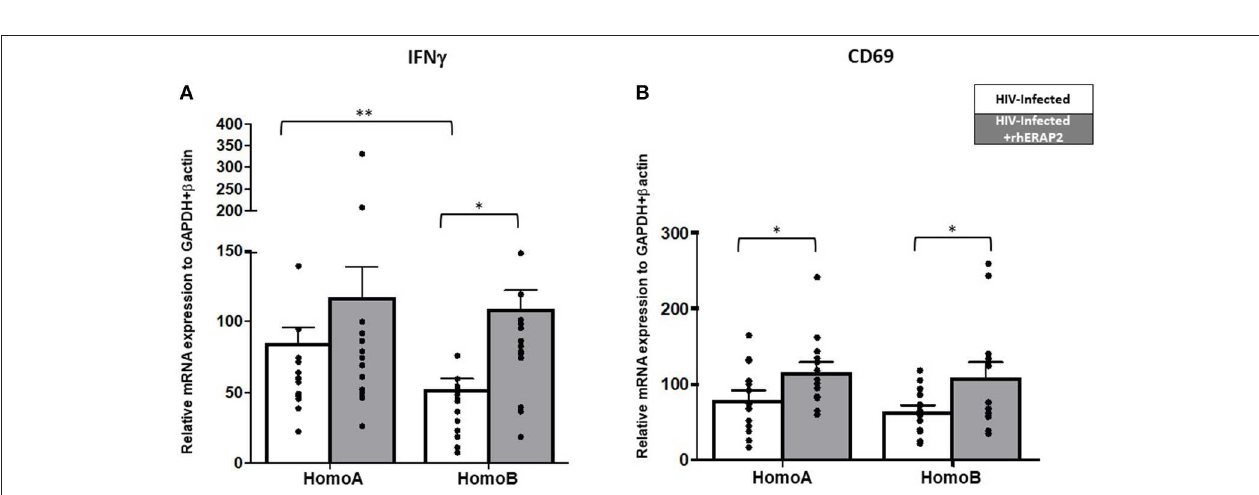
FIGURE 2 | Susceptibility to in vitro HIV-1 infection was reduced in peripheral blood mononuclear cells (PBMCs) and CD8-depleted PBMCs (CD8 − PBMCs) treated with recombinant human ERAP2 (rhERAP2). (A) PBMCs from 3 subjects were treated with different doses of rhERAP2 (10, 100, 1,000ng/ml) and in vitro infected with a R5 HIV1Ba-L. (B) PBMCs from 14 HomoA and 16 HomoB individuals were untreated (white bars) or treated (gray bars) with 100ng/ml of rhERAP2 and in vitro infected with a R5 HIV1Ba-L. (C) CD8 − PBMCs from 4 HomoA and 4 HomoB individuals were untreated (white bars) or treated (gray bars) with 100ng/ml of rhERAP2 and in vitro infected with a R5 HIV1Ba-L. P24 concentration was measured by ELISA 6 days post in vitro HIV-1 infection supernatants in all the experiments. Mean values and SEM are shown. * p < 0.05; ** p <